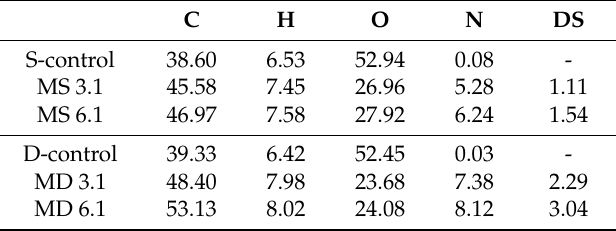
Table 1. Elemental composition of unmodified and modified starch and dextrin.